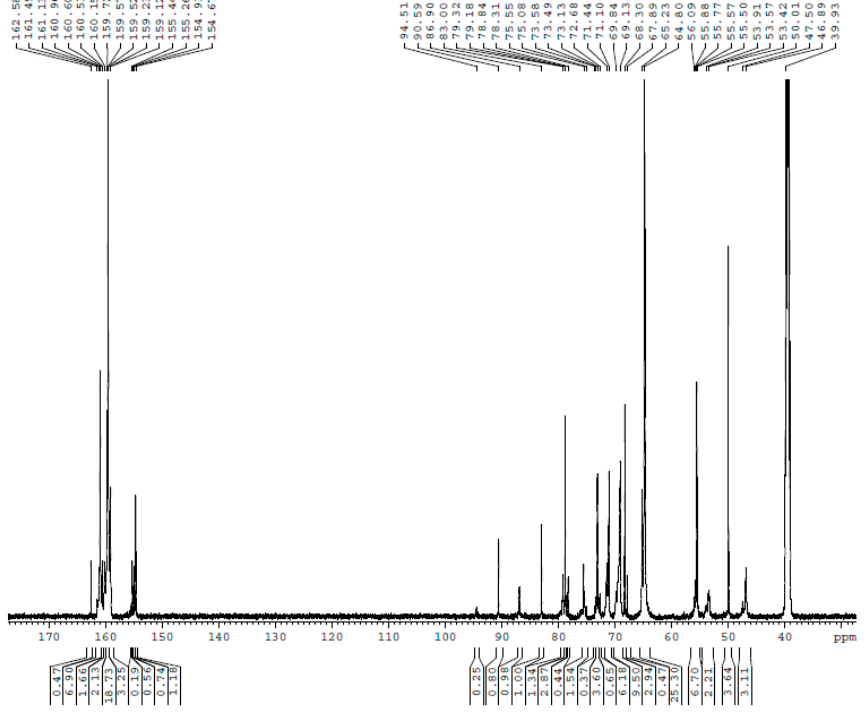
Figure 2. The 13 C NMR spectrum of sample